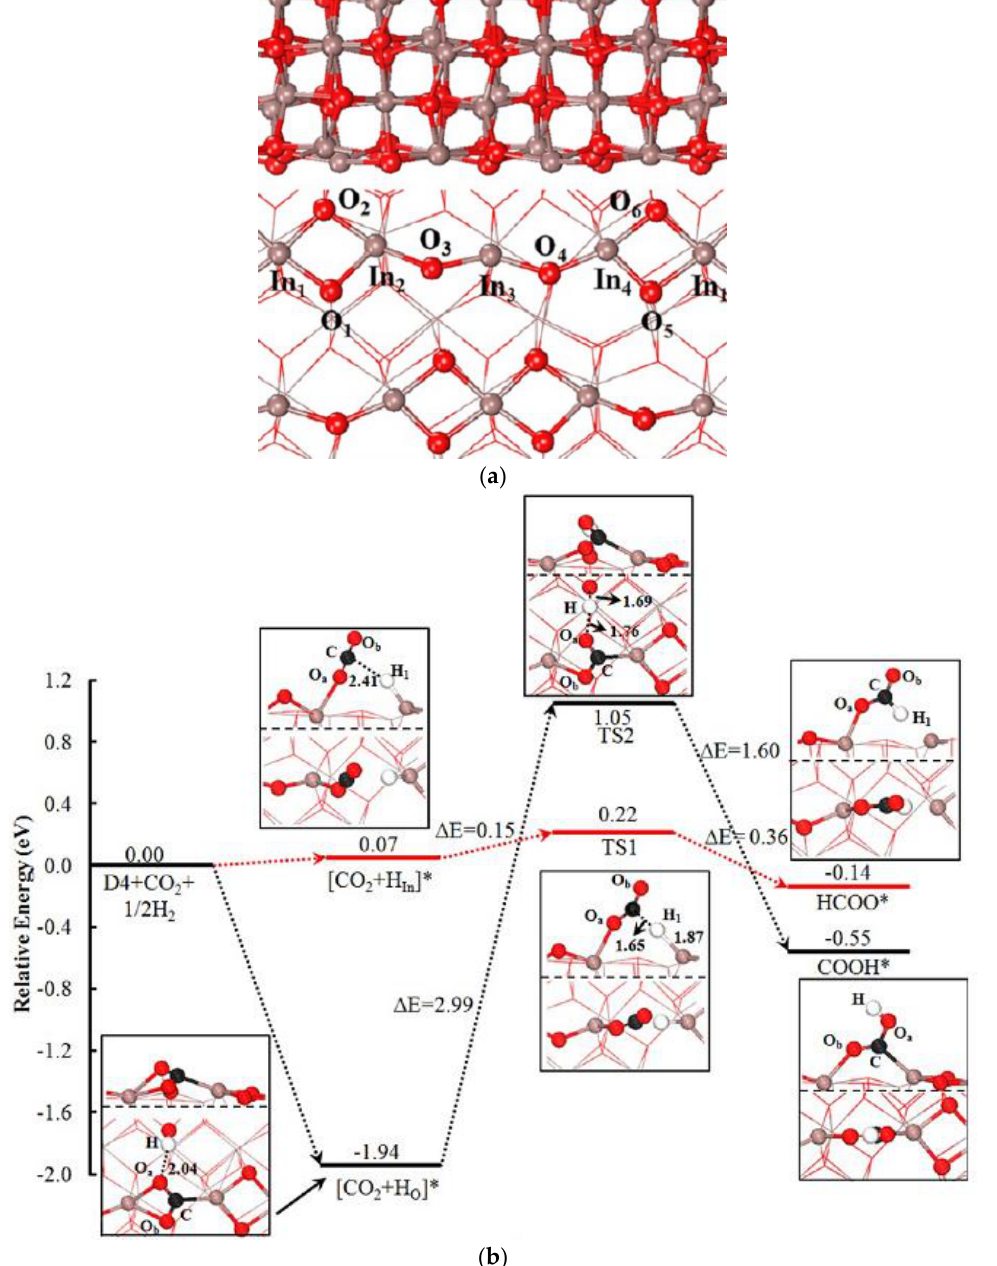
Figure 11. ( a ) Optimized structure of the In 2 O 3 (110) surface. Red: O atoms; brown: In atoms. ( b ) Potential energy profiles of CO 2 hydrogenation and protonation on the D4 defective In 2 O 3 (110) surfaces. Red line: hydrogenation; black line: protonation. A* represents the adsorption state of A on the surface, while [A+B]* represents the co-adsorption state of A and B on the surface, reproduced with permission from [47]. Copyright American Chemical Society, 2013.